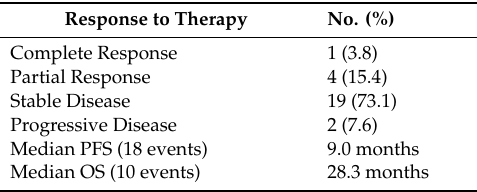
Table 2. E ffi cacy estimates of second-line